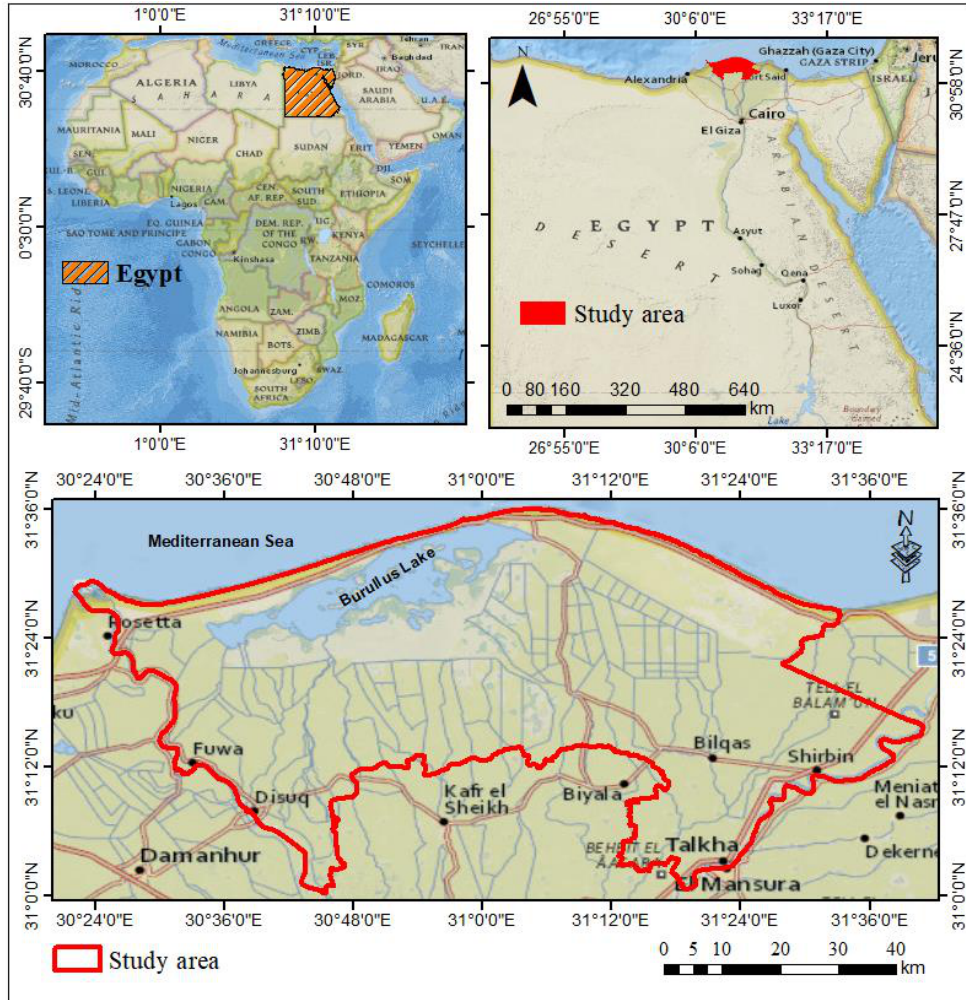
Figure 1. Location maps of the study area.